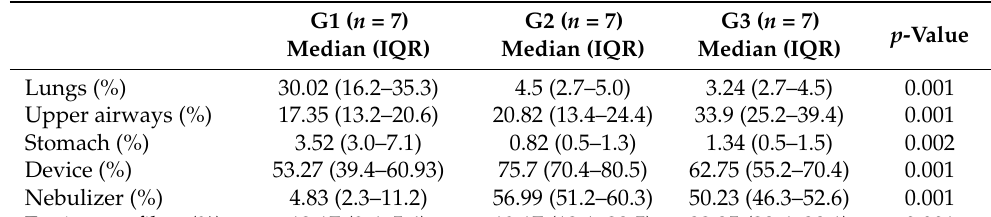
Figure 3. Pulmonary and extrapulmonary ROIs that are used to quantify aerosol deposition and calculated the mass balance across compartments including ( A ) total lung regions, ( B ) stomach, ( C ) upper airways, ( D ) nebulizer, adapter and expiratory filter.